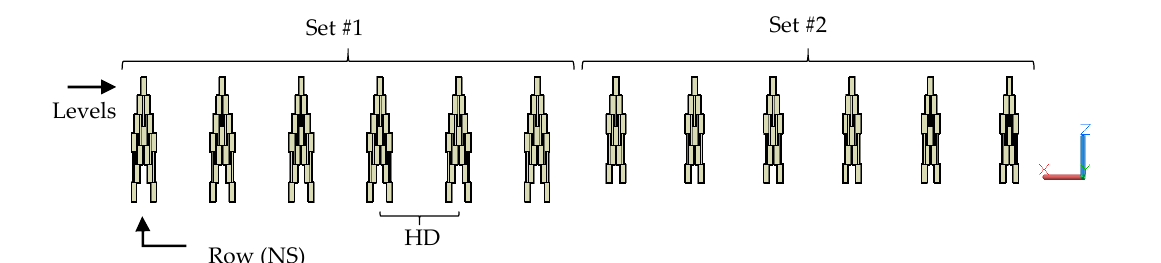
Figure 7. Definition of the various parameters in the pyramidal arrangement: Sets, HD, and row determination.